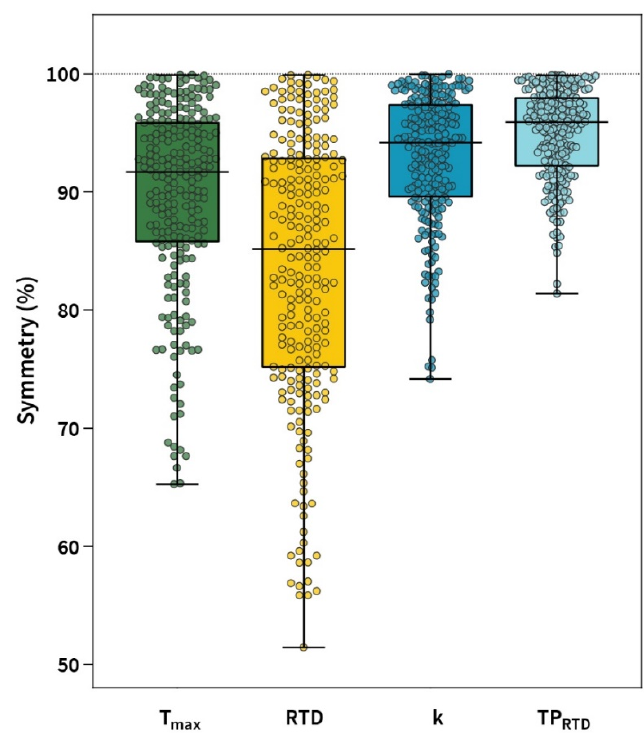
Figure 2. Inter-limb symmetry of knee extensors for different outcome measures. T max -maximal iso- metric torque; RTD-rate of torque development; k-slope of regression line (rate of force development scaling factor); TP RTD -theoretical peak of RTD. Table 5. Leg dominance agreement between T max (the reference outcome measure) and other outcome